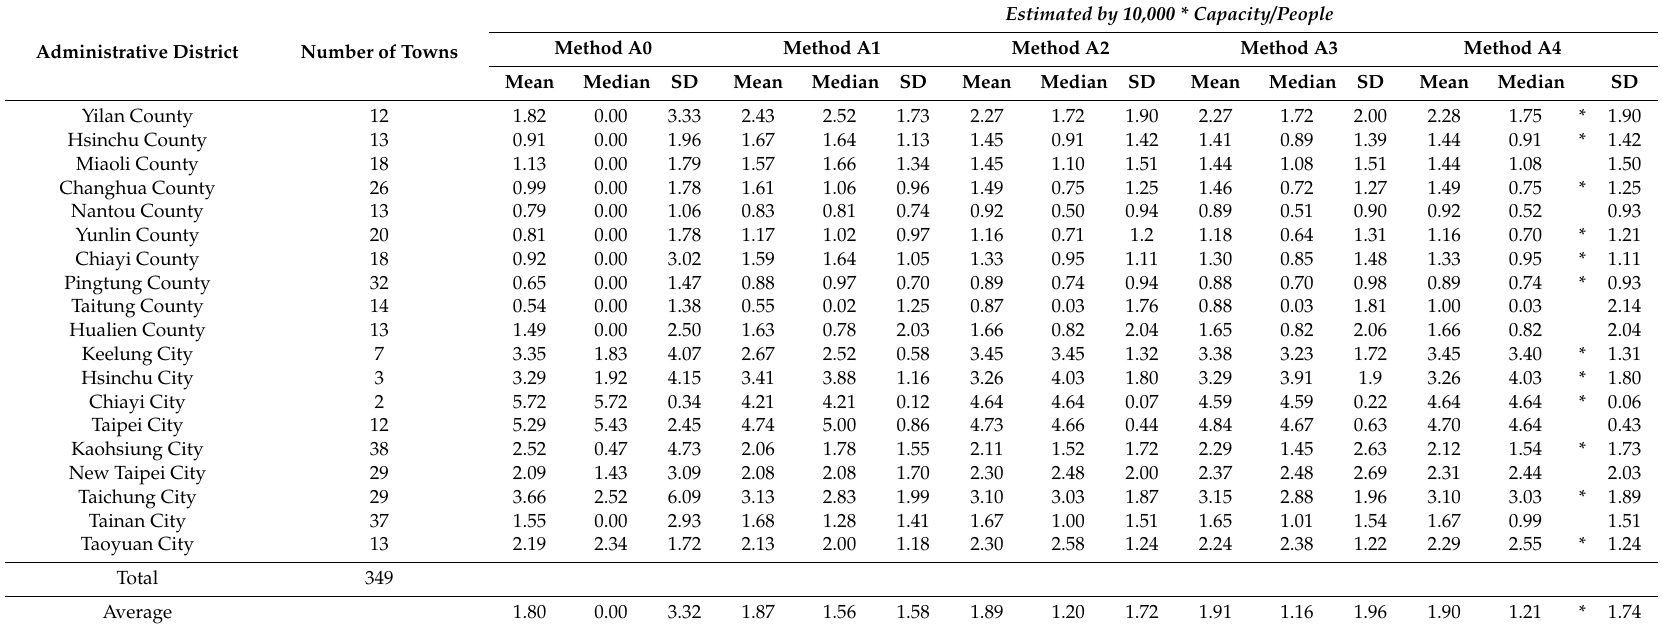
Table 5. Summary statistics of physical rehabilitation resources accessibility scores by methods